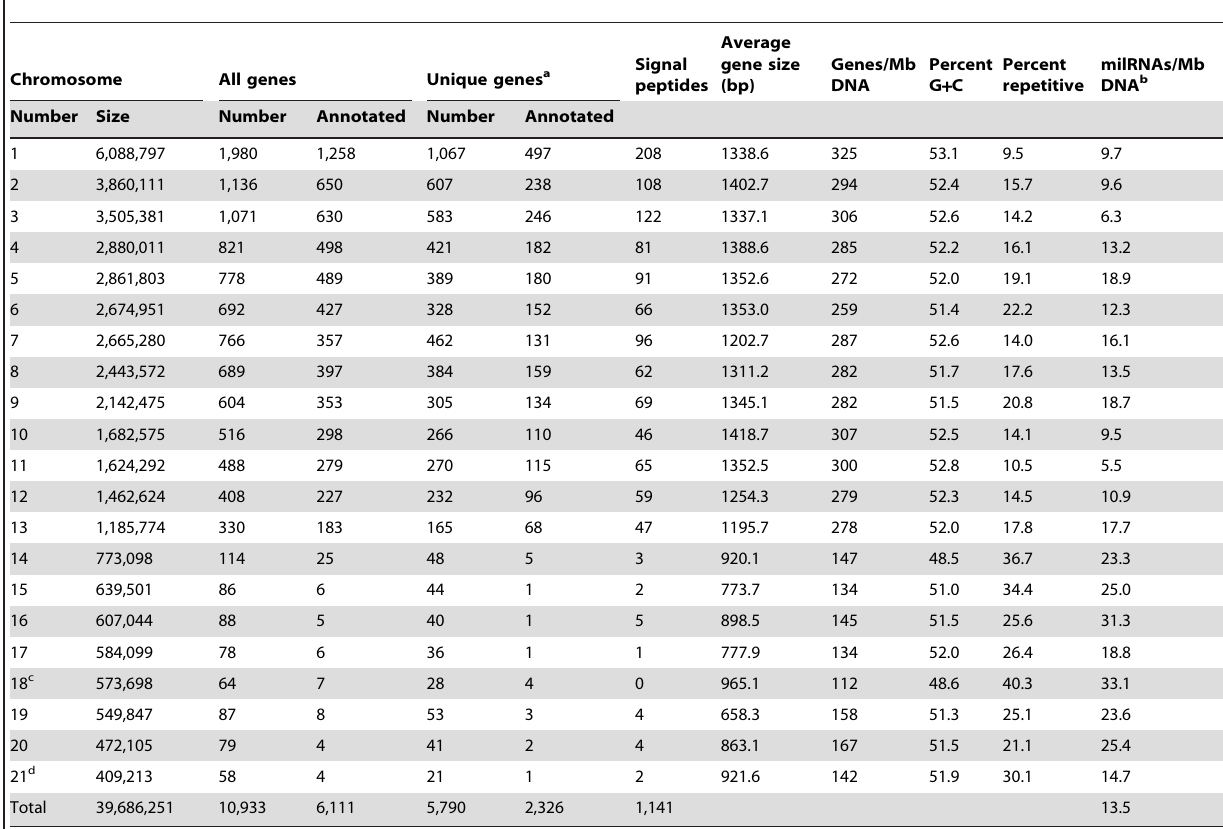
Table 1. Sizes and gene contents of the 21 chromosomes of Mycosphaerella graminicola isolate IPO323.